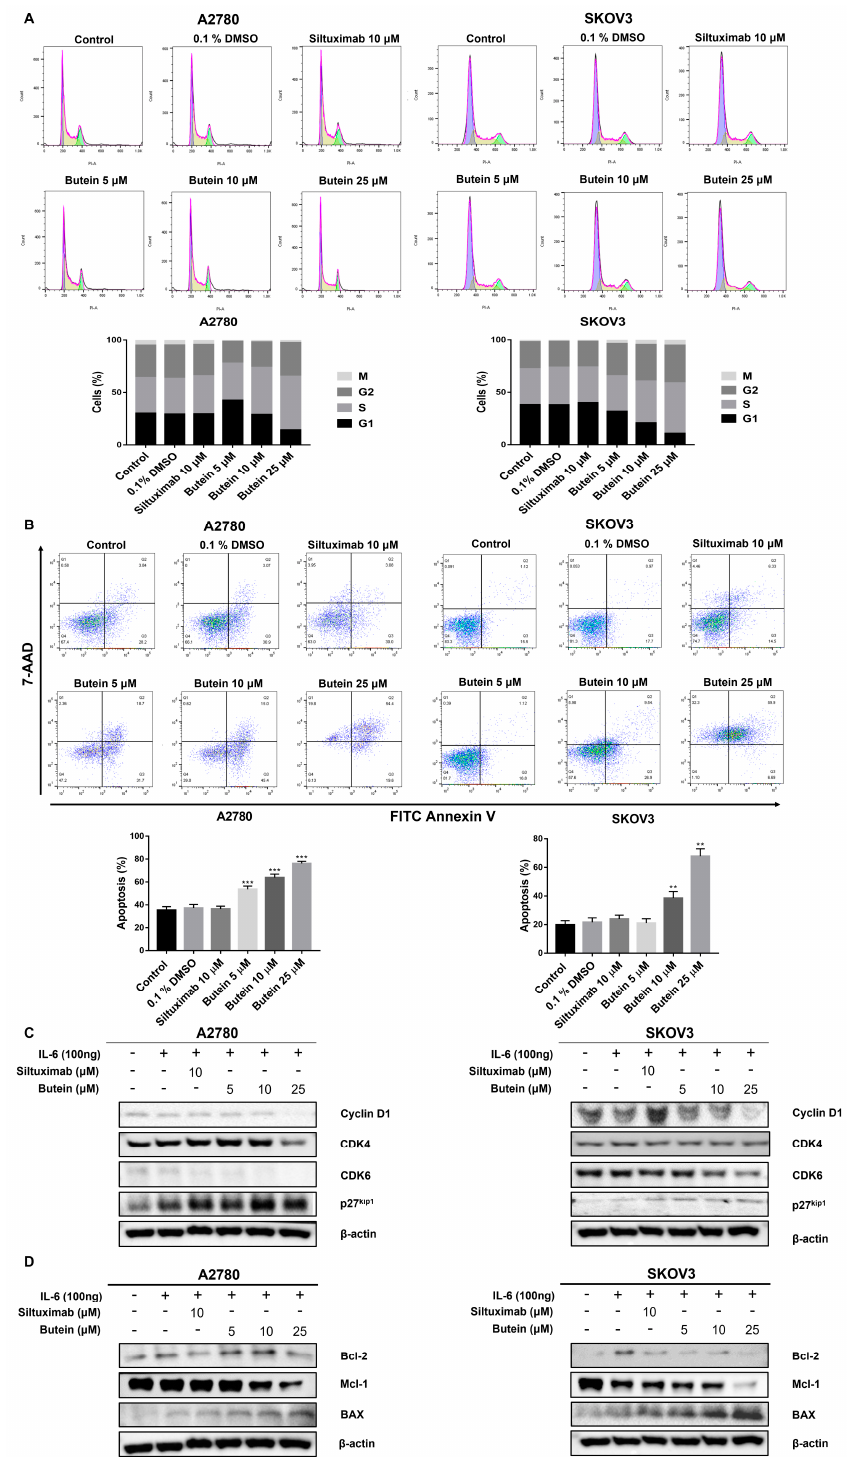
Figure 4. Butein induced growth arrest and apoptosis of ovarian cancer cells. ( A ) Butein induced cycle arrest in ovarian cancer cells, which were stained by PI, and cell cycle distribution was analyzed by flow cytometry. ( B ) A2780 and SKOV3 cells were treated with various concentrations of butein in triplicate for 48 h to detect cell apoptosis using the FITC Annexin V apoptosis Kit (** p < 0.01 and *** p < 0.001). ( C ) Butein decreased the expression of Cyclin D1, CDK 4, CDK 6, and increased the expression of p27 kip1 in A2780 and SKOV3 cells. ( D ) Butein decreased the expression of Bcl-2, Mcl-1, and increased the expression of Bax in A2780 and SKOV3